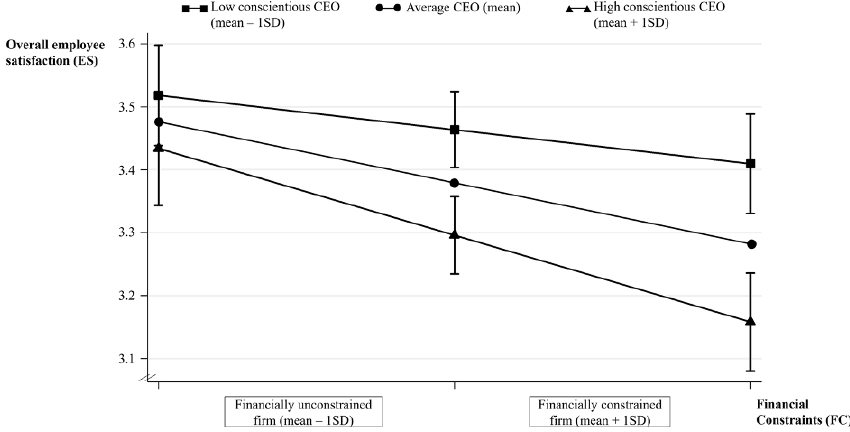
Fig. 4 Moderation effect of CEO conscientiousness on the relation between financial constraints and employee satisfaction (H2), displaying 95% confidence intervals for high and low levels of CEO consci-